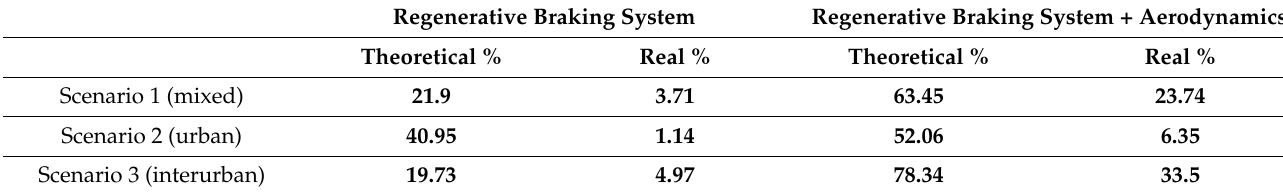
Table 9. Percentage of power recovered by two turbines with R = 0.35